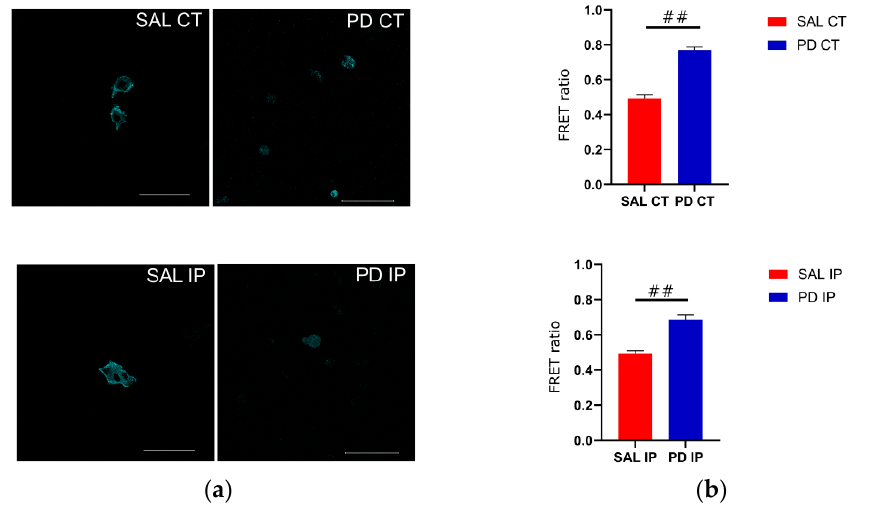
Figure 8. Cells that grew on the striatal decellularized matrices (Scheme 2). ( a ) OS cells expressing the actinin-sstFRET mechanosensor and growing on the decellularized matrices of the contralateral and ipsilateral hemispheres from the saline and 6-OHDA-lesioned mice. The cerulean (donor) image is shown; scale bar 100 μ m. ( b ) Comparison of the calculated FRET ratio for all of the conditions, cells growing in the contralateral and ipsilateral hemispheres from the saline (SAL CT and SAL IP) and 6-OHDA-lesioned (PD CT and PD IP) mice. Values are shown indicating the mean value + SEM. One-way ANOVA followed by Bonferroni post hoc test was performed (## p < 0.001). The sampling distribution was first tested for normality using the Shapiro − Wilk test and for the homogeneity of variances using the Levene’s test.